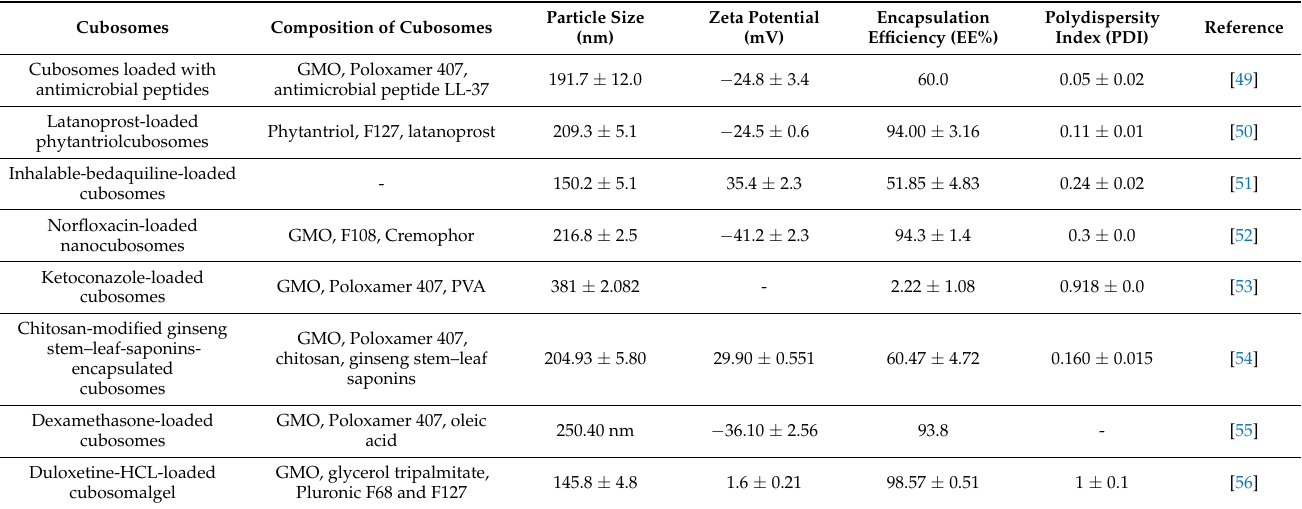
Table 3. Physical–chemical characterization of drugs-loaded